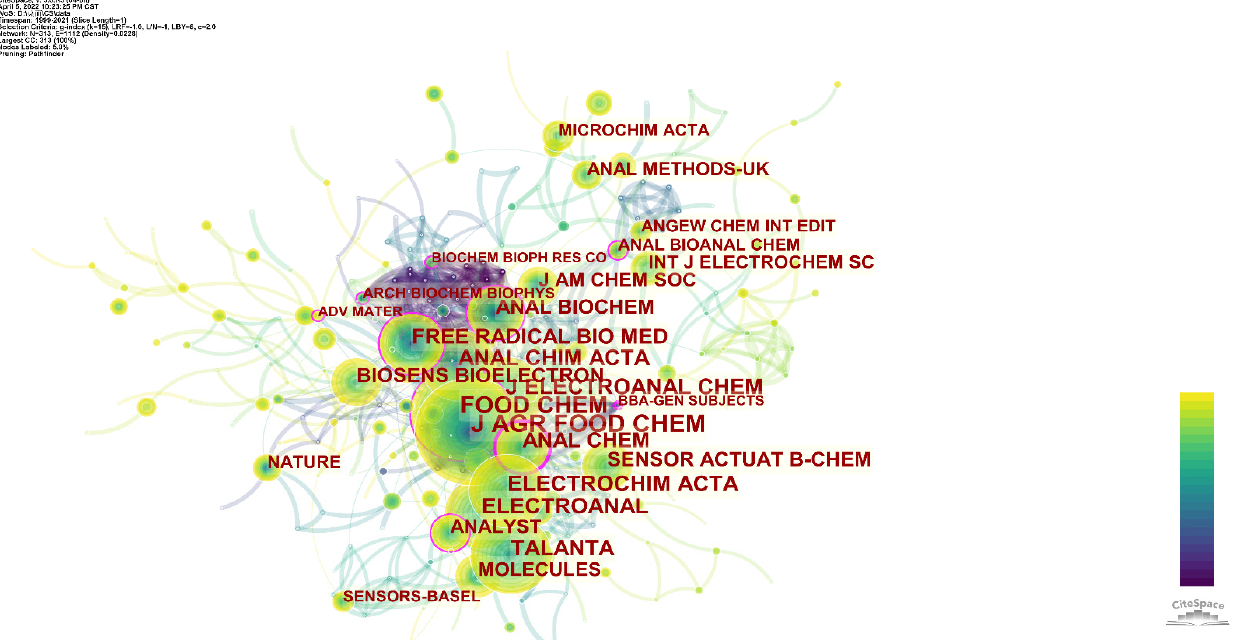
Figure 3. Co-occurrence network of cited journals for evaluation of antioxidants using electrochem- ical sensors.